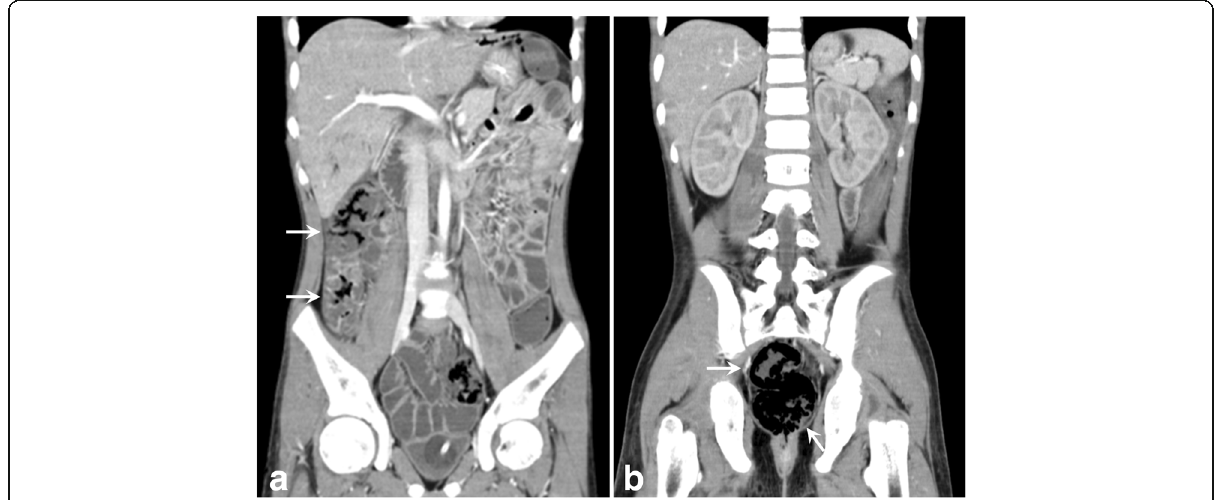
Fig. 1 Contrast-enhanced abdominal computed tomography (CT). Emergency CT scans revealed pneumatosis intestinalis (arrows) localized in the ascending colon ( a ) and the rectum ( b ) coexisting with portal venous